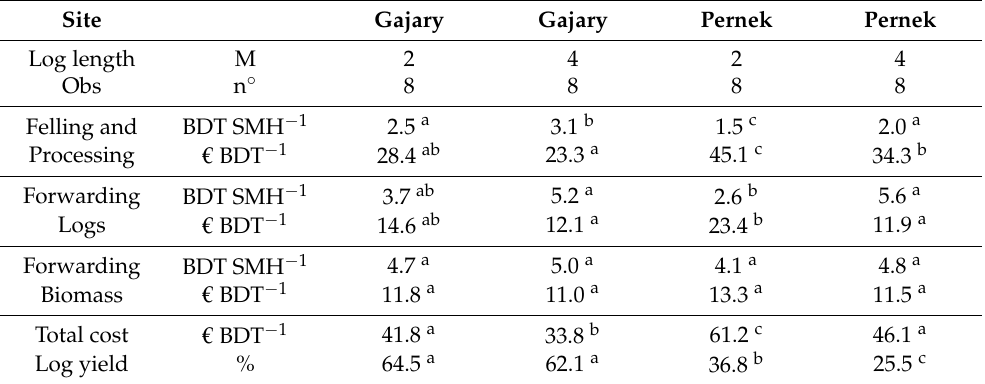
Table 2. Harvesting productivity and